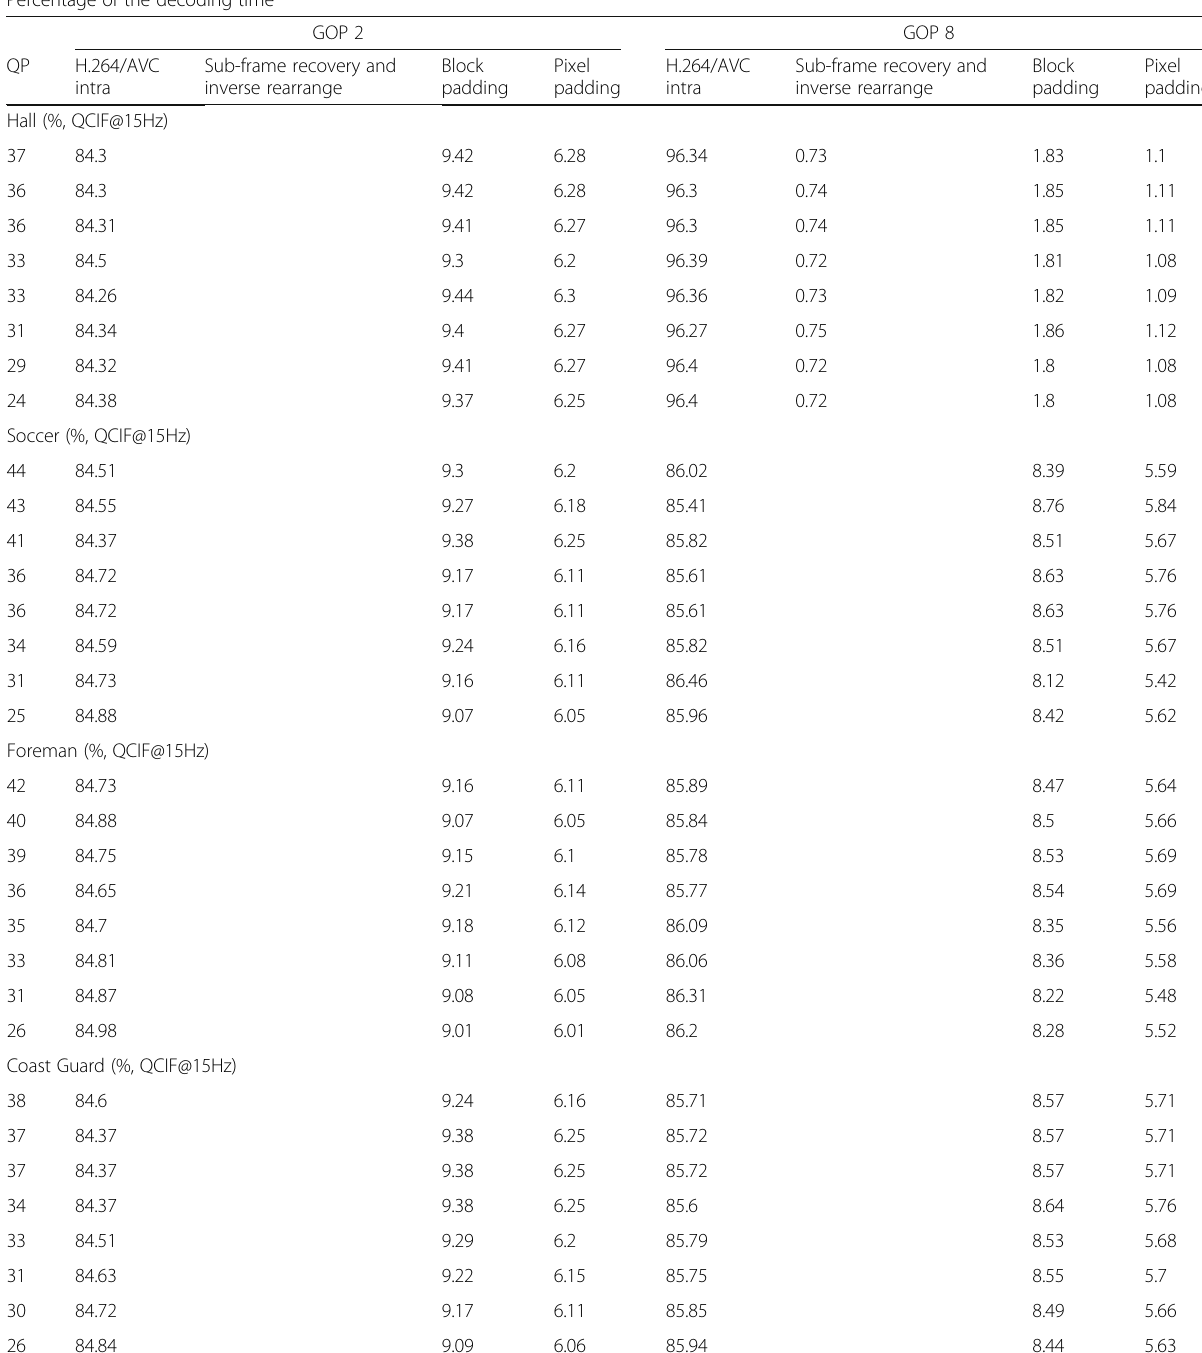
Table 4 The decoder time percentage of the proposed PB-based